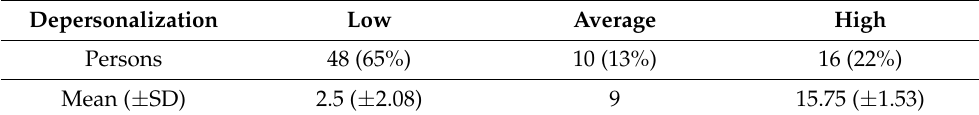
Table 5. Percentage of depersonalization.